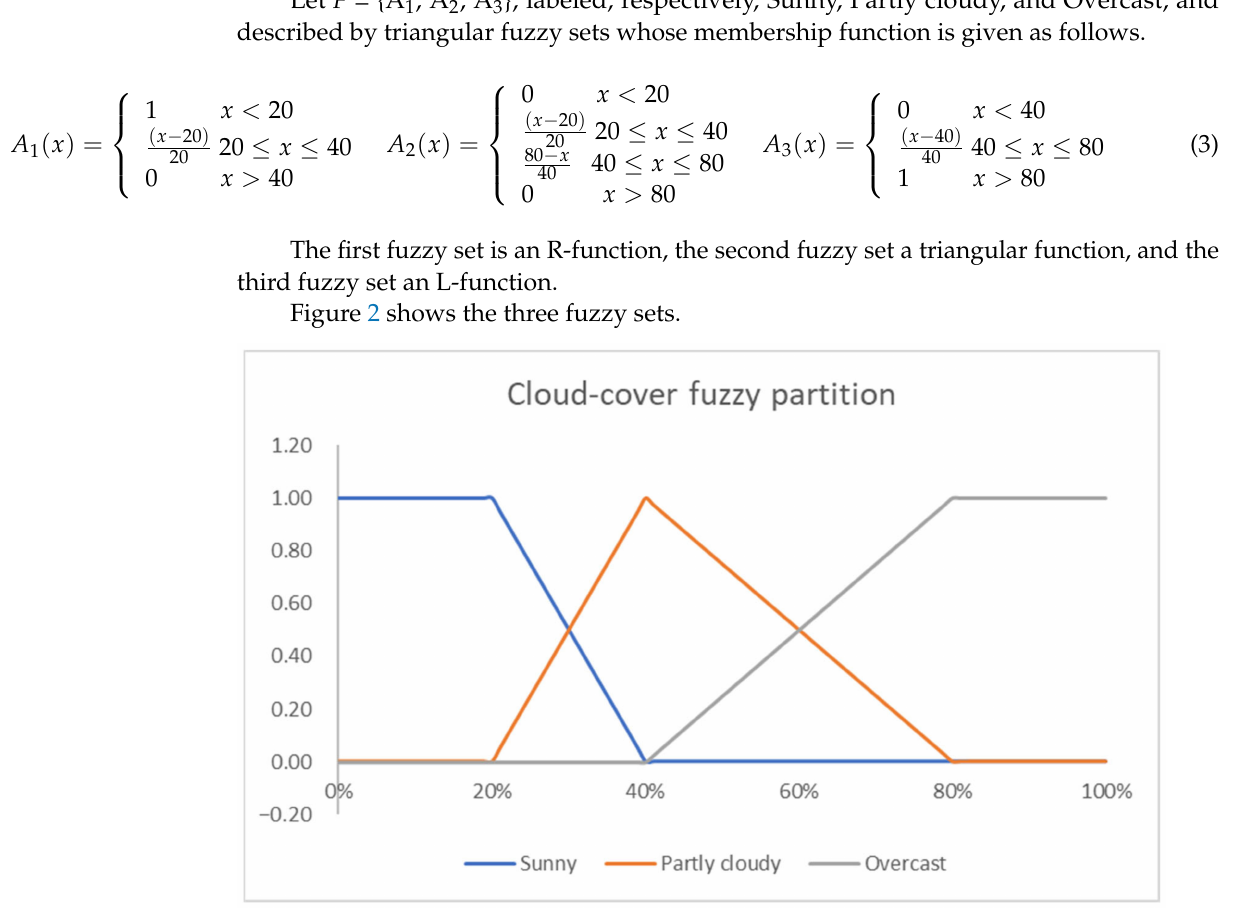
Figure 2. Example of fuzzy partition built using fuzzy numbers. F is a fuzzy partition as the constraints (1) and (2) are